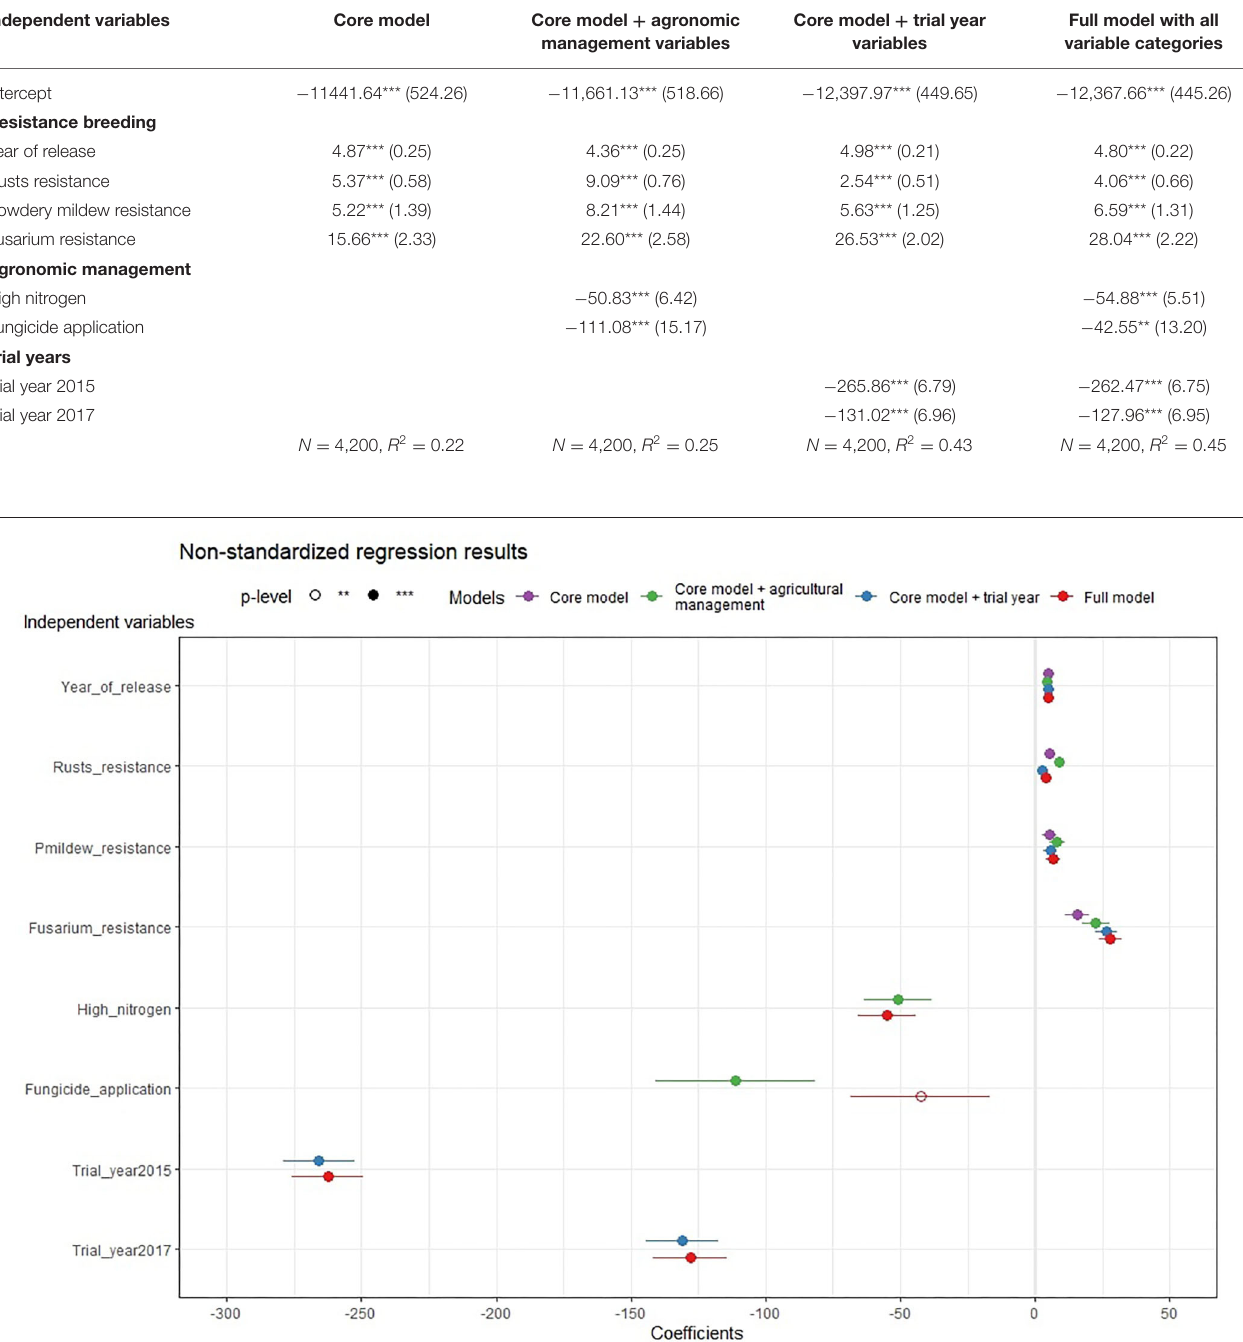
Frontiers in Agronomy |